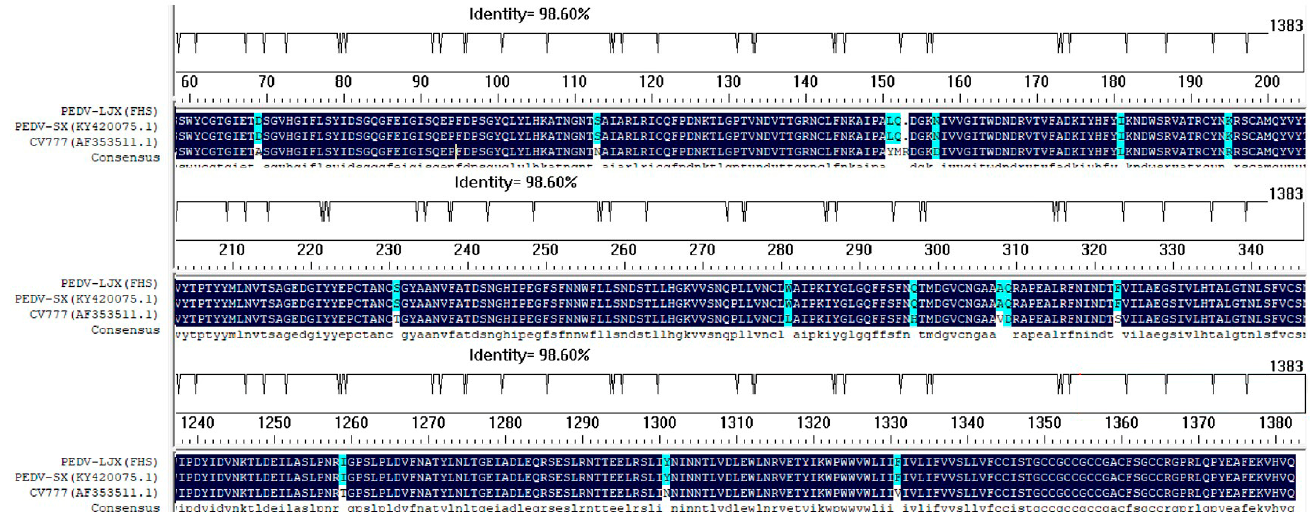
Figure 3. Alignment of S protein sequences in different PEDV strains. Reference S protein sequences obtained from GenBank are indicated by their strain names and GenBank accession numbers. The mutated amino acids in the S protein in PEDV-LJX are indicated in blue.